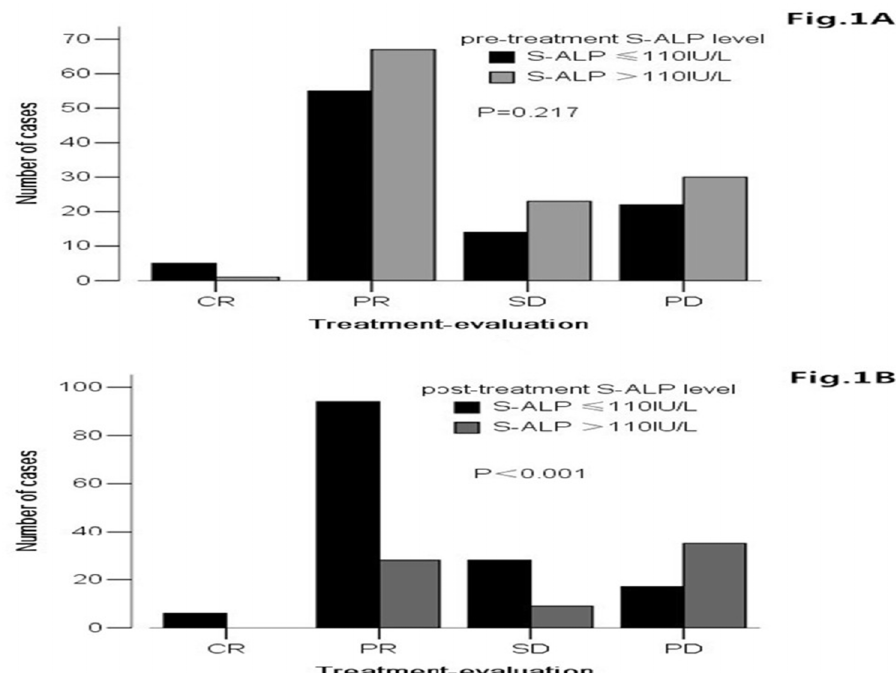
Figure 1 - Correlation between the pre-treatment (and post-treatment) S-ALP level with the treatment responses of the 217 patients who had measurable lesions. A) Pre-treatment S-ALP level and the treatment response are shown (chi-square test, P =0.217). B) Post- treatment S-ALP level and the treatment response are shown (chi-square test, P o